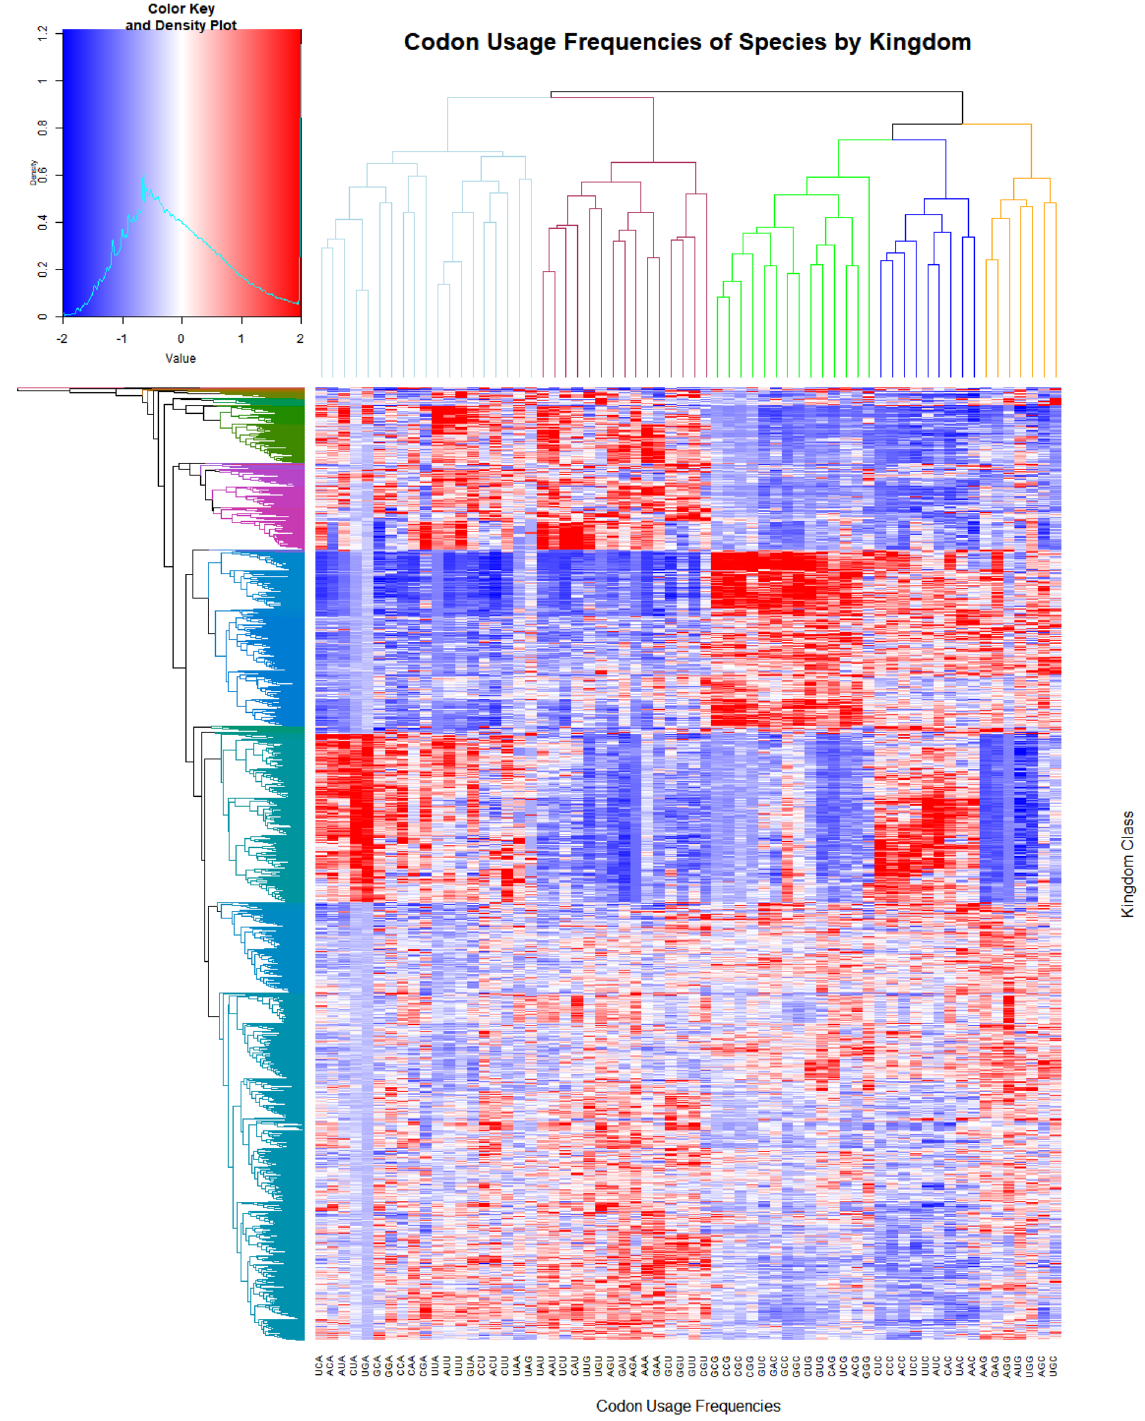
Figure 2. Heatmap visualization of species’ codon usage frequencies by kingdom class. The horizontal axis denotes all 64 codon usage frequencies of a species, while the vertical axis is separated by our kingdom discrimination. Red color represents a high relative codon frequency while blue is low. Rows that have a similar color profile represent phylogenetically close organisms sharing a nearly homogeneous codon usage